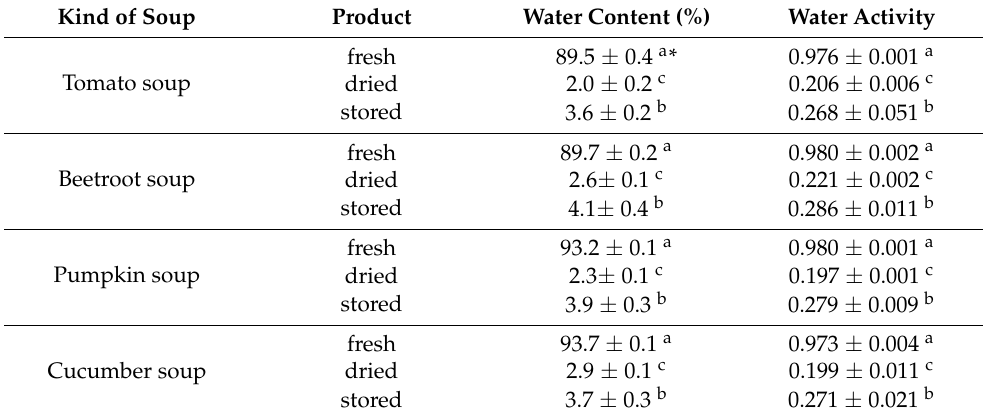
Table 4. Water content and water activity of different fresh freeze-dried and stored soups.